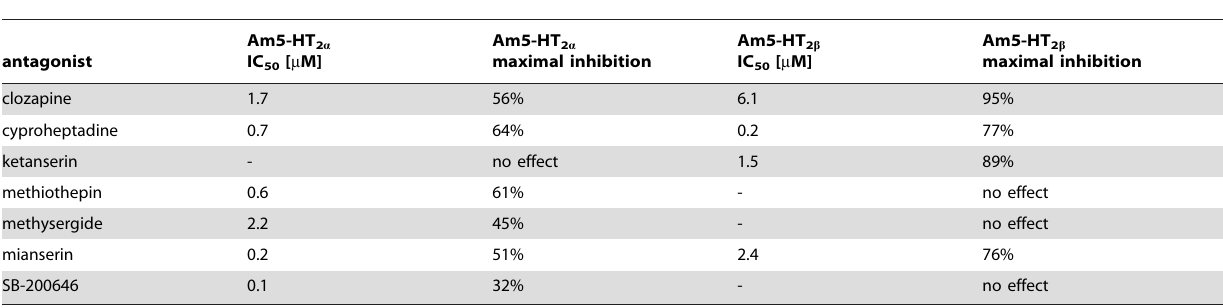
Table 1. Antagonist profile of Apis mellifera 5-HT 2